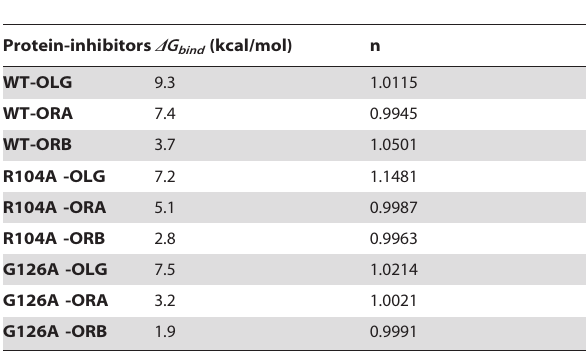
Table 2. The calculated energy components, the binding free energy (kcal/mol) of OLG, ORA, and ORB binding to the active site of a